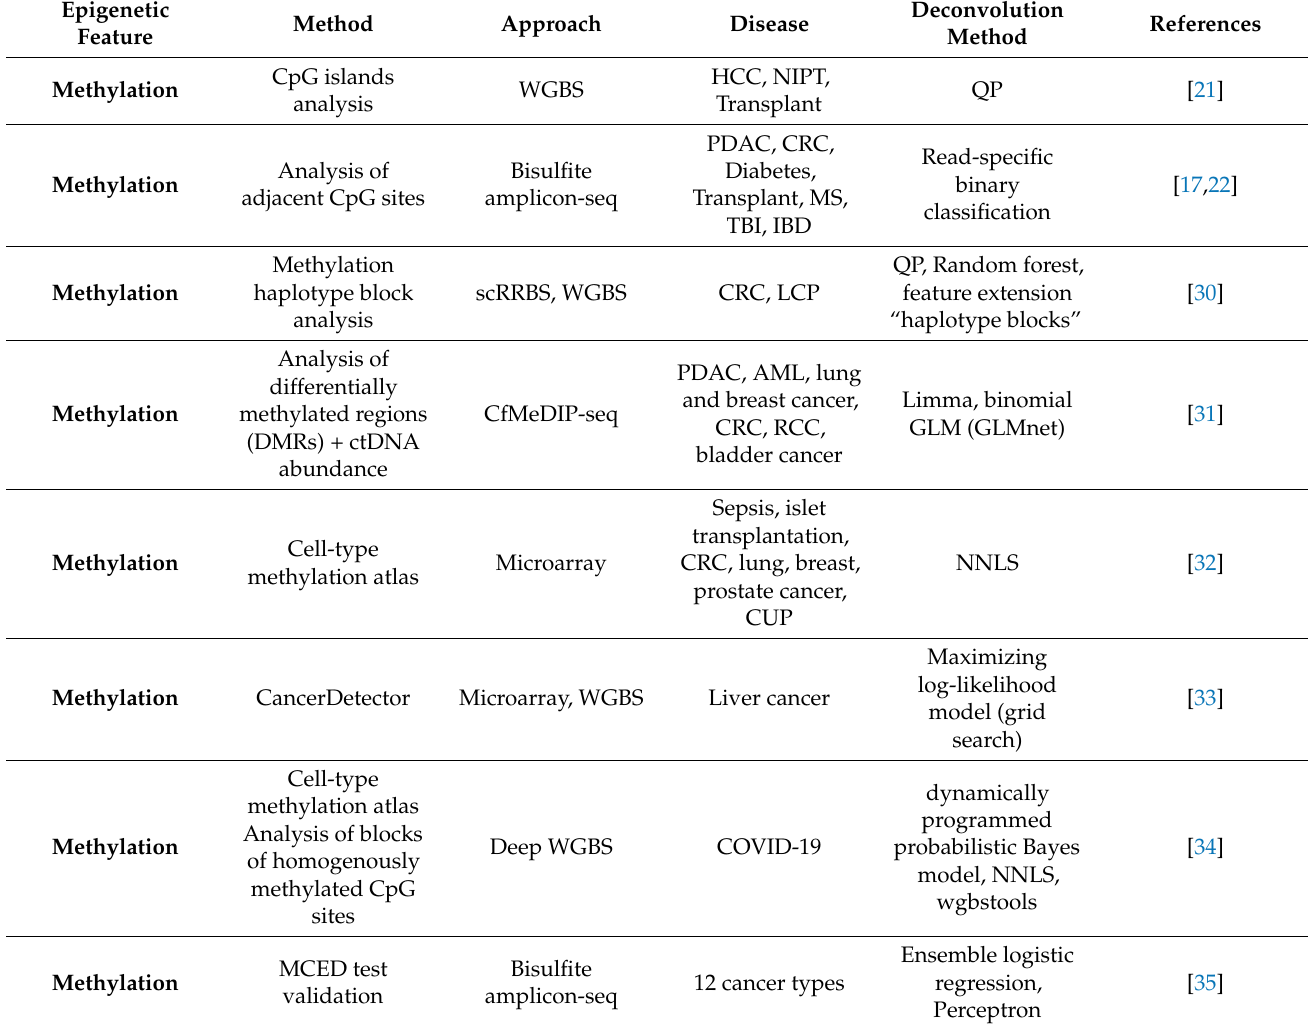
Table 1. Overview of key studies that performed tissue-of-origin analysis on cfDNA using various approaches based on methylation patterns, nucleosome positioning patterns, TFBS occupancy, histone modifications, and fragmentomics. The data literature search was performed with the PubMed NCBI database. All deconvolution methods listed in this table are reference-based and employ a classification, unless stated